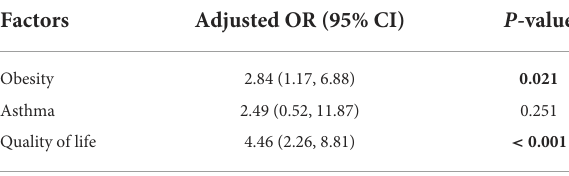
TABLE 5 Multivariate analysis of associated factors for high-risk OSA in ADHD children ( n = 274).